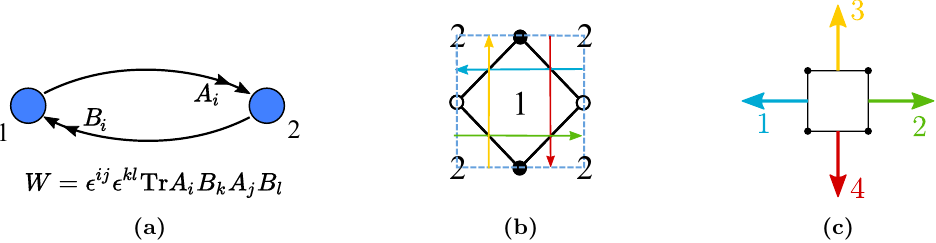
Figure 1. Conifold: (a) quiver diagram and superpotential, (b) dimer diagram with ZZPs, and (c) toric diagram with outward normals corresponding to